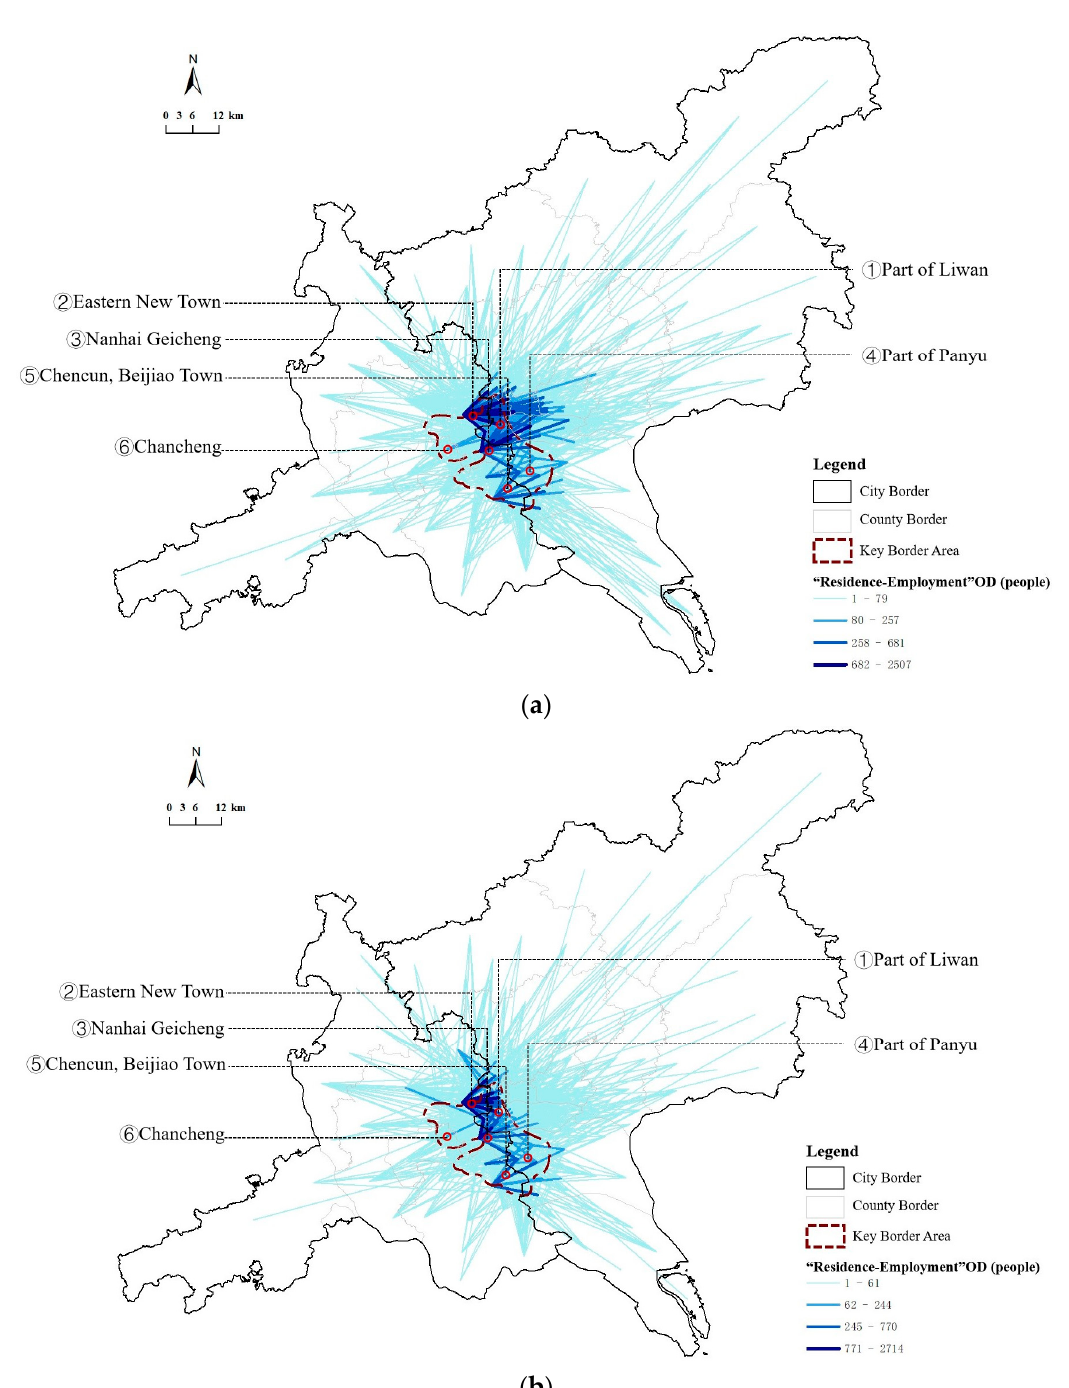
Figure 6. “Resident-employment” OD travel streamline of 2019. ( a ) The starting point (o) is in the border area; ( b ) The terminus (d) is in the boundary area.